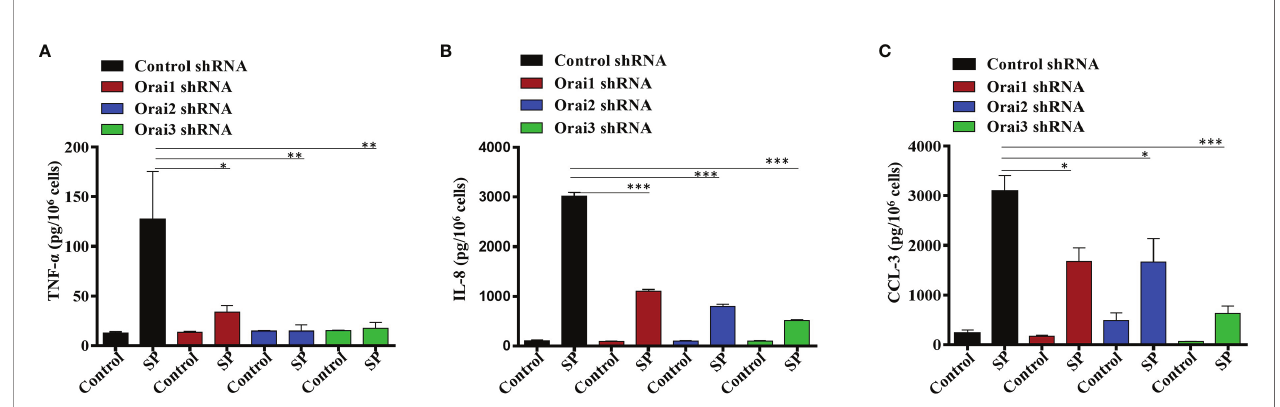
FIGURE 2 | Orai1, Orai2, and Orai3 contribute to SP-Induced Cytokines Generation in LAD2 Cells. LAD2 cells with shRNA-mediated knockdown of each Orai channel or non-targeted (control) cells were exposed to SP (1 µM, for 24 h). Culture supernatants were used to quantitate (A) TNF- a , (B) IL-8 and (C) CCL-3 by ELISA. Data presented are mean ± SEM of N = 3 experiments. Statistical signi fi cance was determined by one-way ANOVA with Tukey ’ s multiple comparisons at a value ***p < 0.001, **p < 0.01 and *p